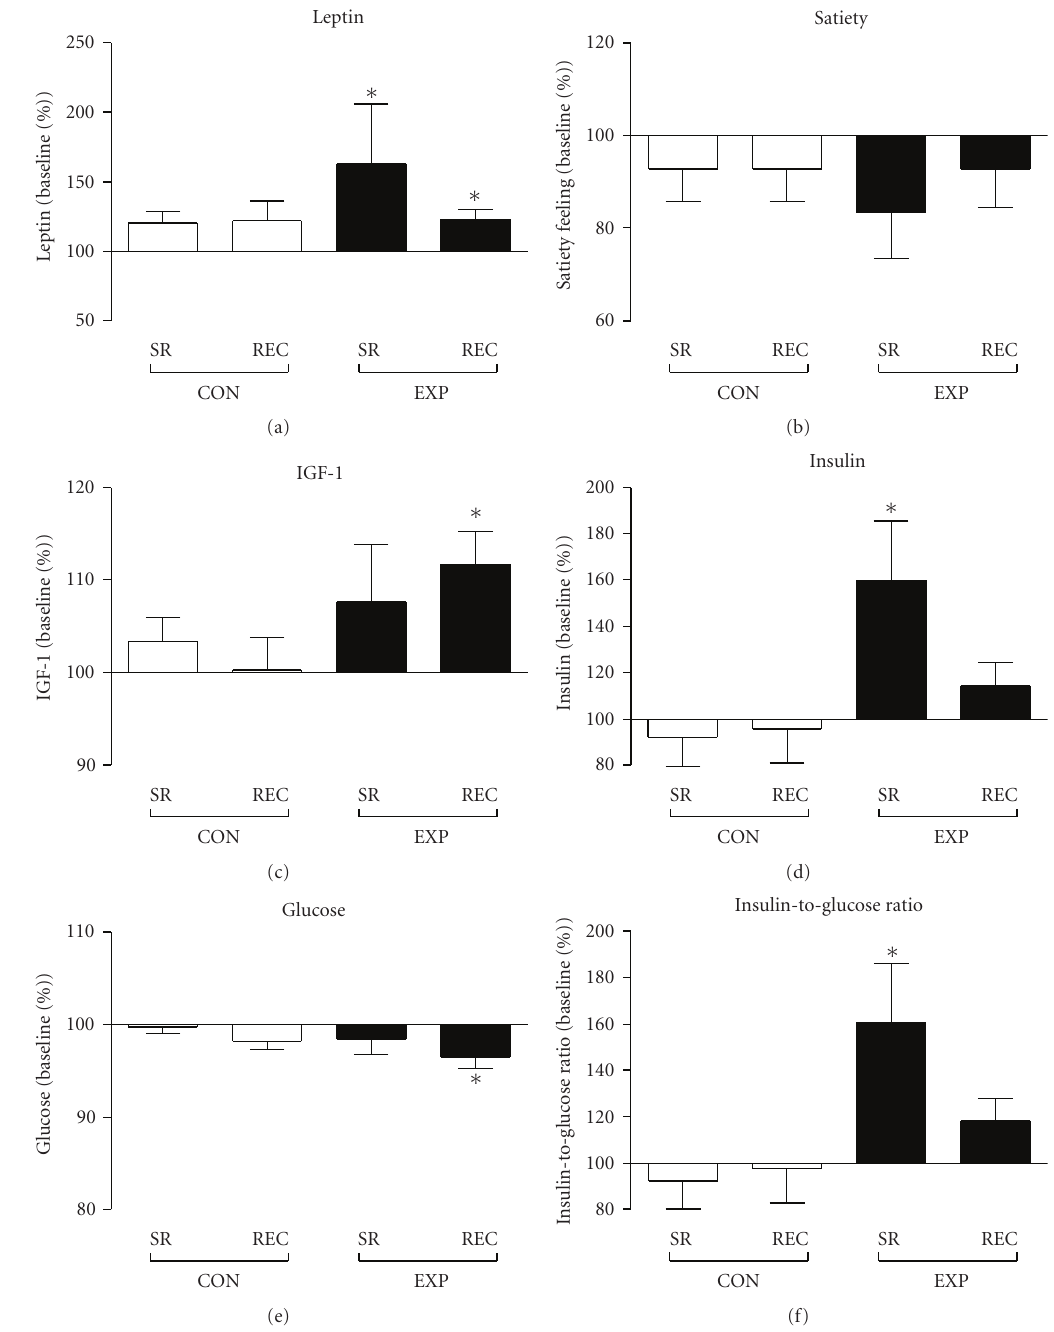
Figure 2: Changes in serum concentrations of leptin, IGF-1, insulin, and glucose, and changes in insulin-to-glucose ratio and subjective satiety after sleep restriction (SR) and recovery (REC) in the control group (CON) and experimental group (EXP). Data are expressed as percentages of participant’s individual baseline values (mean ± SEM) ( ∗ P < .